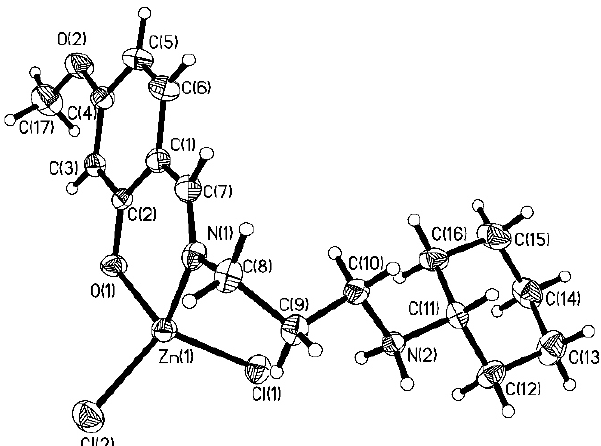
Table 2. Atomic coordinates and displacement parameters (in Å 2 )